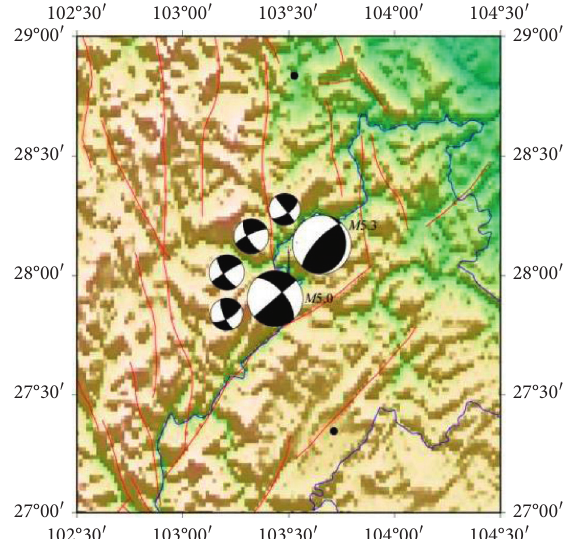
Figure 8: Focal mechanism distribution of M5.3 and 5.0 earthquakes and M4 aftershocks in